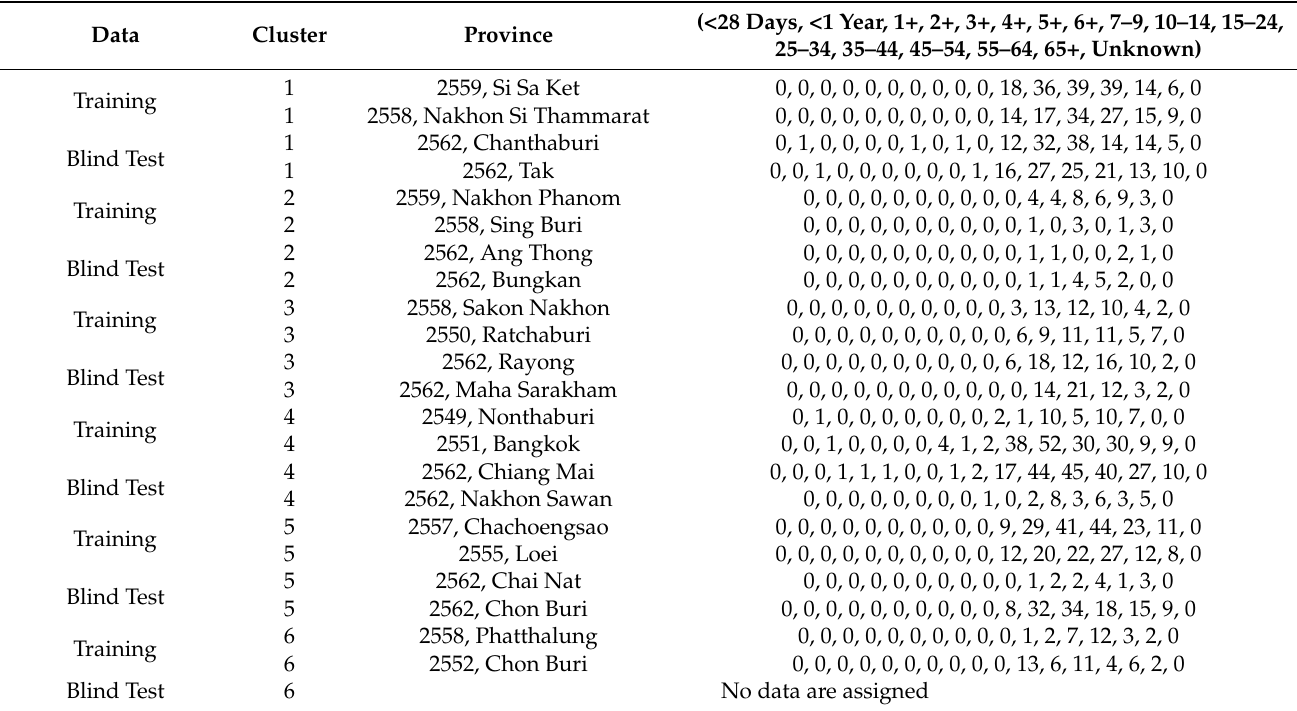
Table 15. The example of clustering results from the selected models for the HBV dataset for the age range category. Data